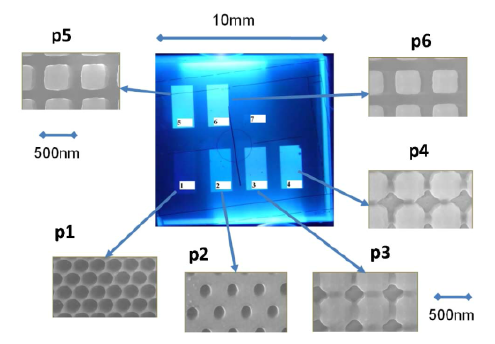
Figure 11. PhCs produced with e-beam lithography in Si 3 N 4 on a scintillator